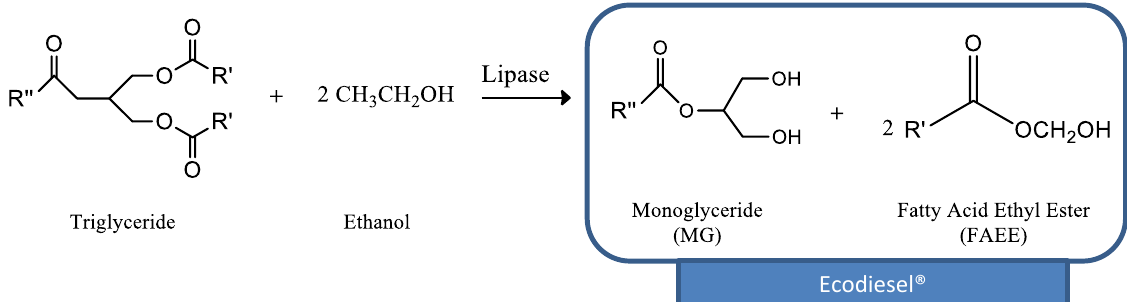
Figure 1. Selective transesterification of a triglyceride molecule through the application of enzymatic catalysis to produce Ecodiesel ® .